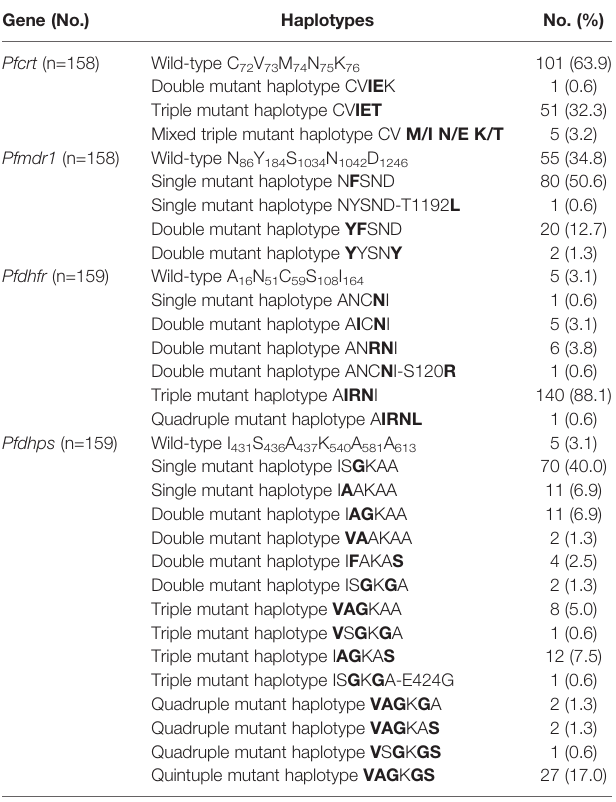
TABLE 2 | Haplotypes of Pfcrt , Pfmdr1 , Pfdhfr , and Pfdhps genes detected in Plasmodium falciparum isolates returned from Nigeria during 2012 – 2019. Gene